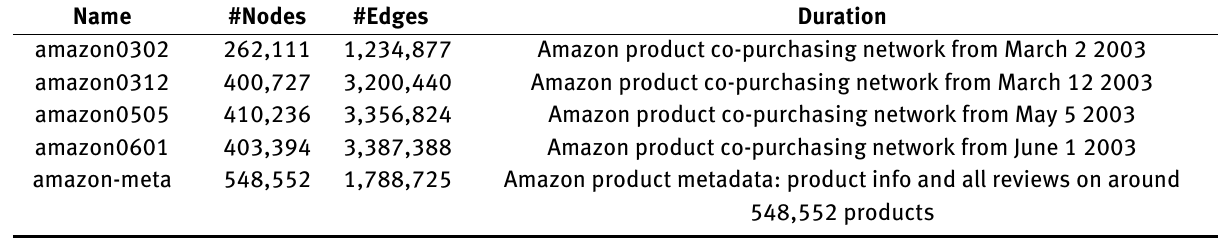
Table 2: The information of Amazon co-purchasing network